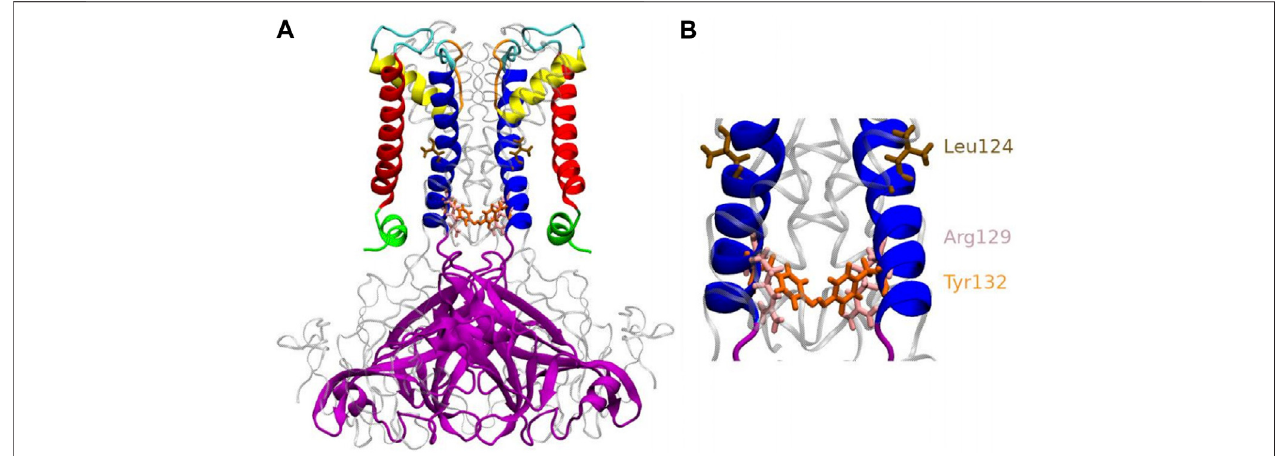
FIGURE1| AnatomyofKirBac3.1S129RfromthemodeledKirBac3.1S129R (A) ThetransmembraneportionofeachmonomerofKirBac3.1iscomposedoffour helices: slide helix (green), transmembrane helix 1 (red), pore helix (yellow), and transmembrane helix 2 (blue). The mutation S129R is situated at the level of the helix bundle (pink), at the bottom of the inner helix (B) Leu124 and Tyr132 are shown in color brown and orange respectively. Arg129 is shown in